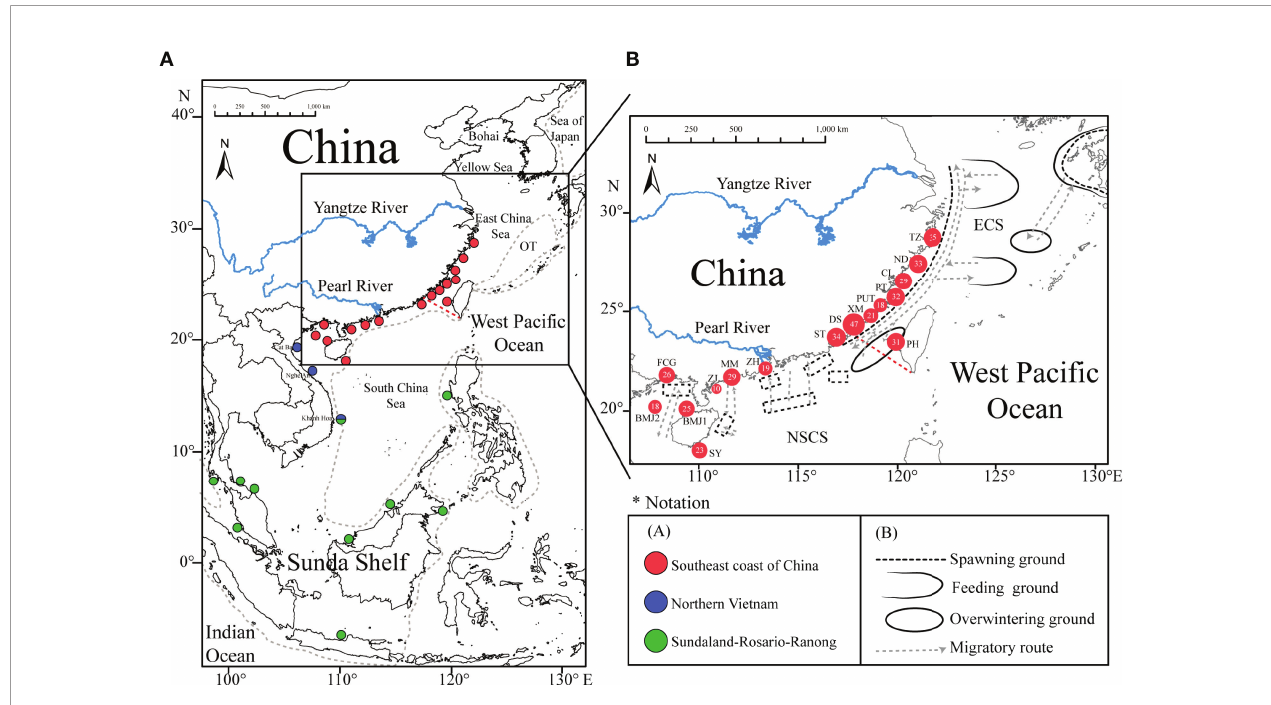
FIGURE 1 | (A) Geographic distribution of Decapterus maruadsi populations used in this study (Niu et al., 2018; Niu et al., 2019; Jamaludin et al., 2020). The shoreline of the LGM (-120 m) is indicated by a grey dashed line and the boundary of the East China Sea (ECS) and the South China Sea (SCS) is indicated by a red dashed line. OT, Okinawa Trough. (B) Sampling locations of 430 D. maruadsi individuals along the southeast coast of China. Populations are marked by abbreviations and the size of each population ’ s circle indicates the number of obtained individuals. Spawning ground, feeding ground, overwintering ground, and migratory capacity of D. maruadsi are shown (Deng and Zhao, 1991; Zheng et al.,